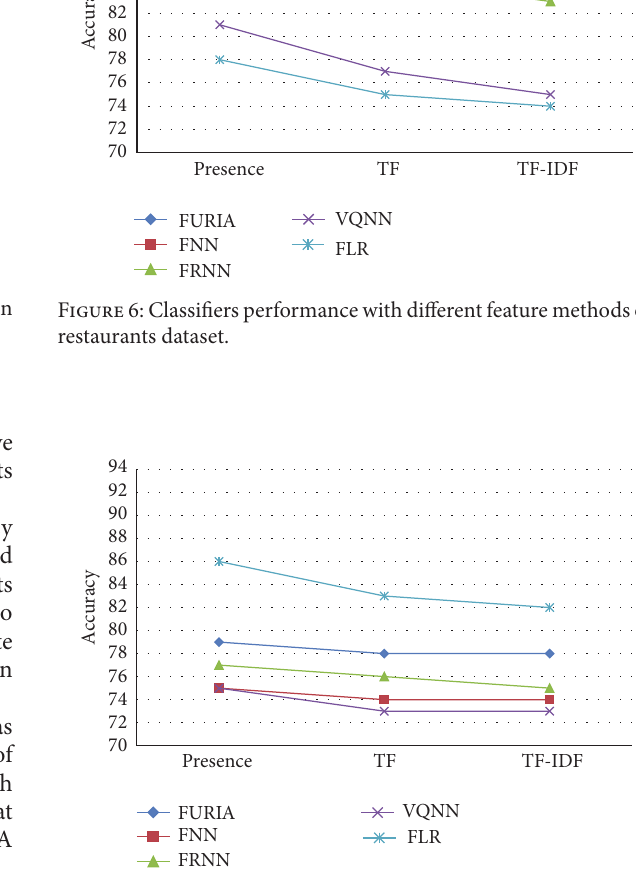
Figure 7: Classifiers performance with different feature methods on hotels